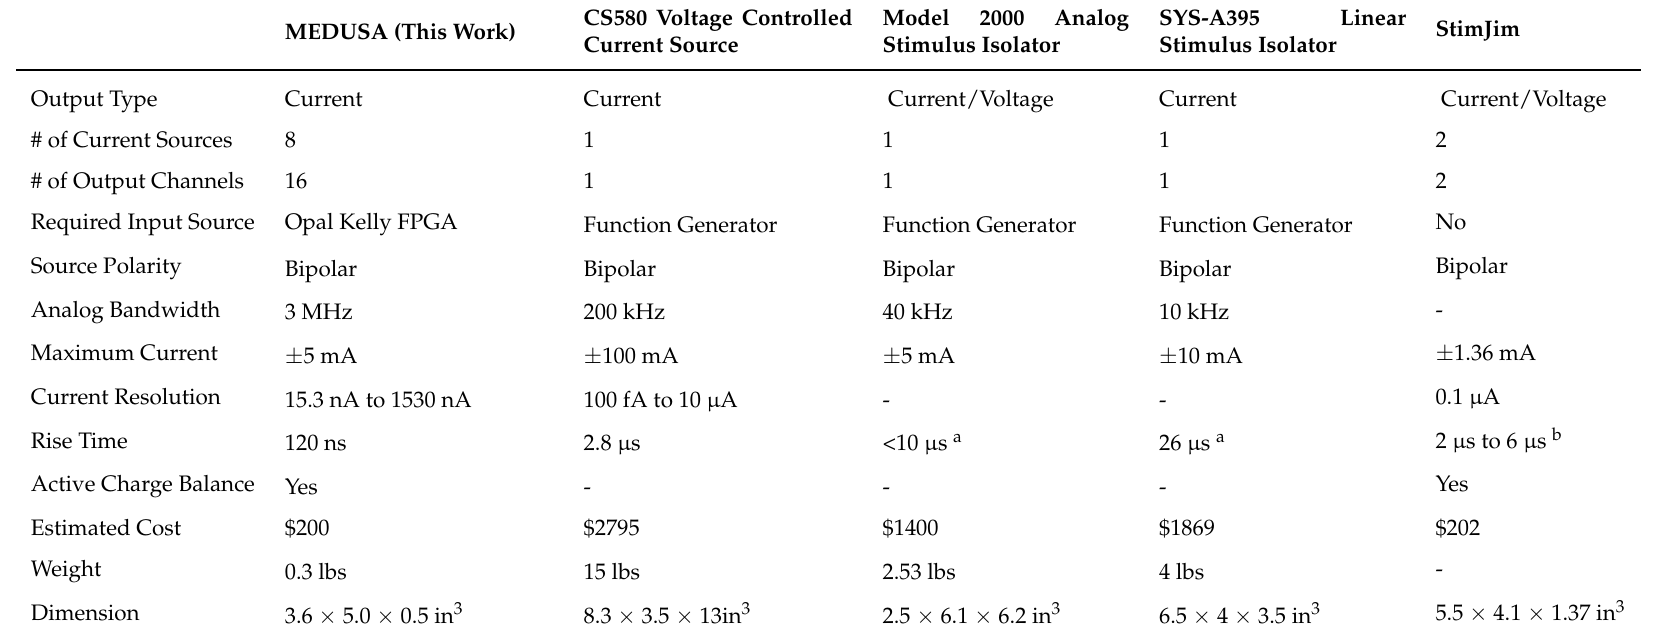
Table 2. Overview of neural current